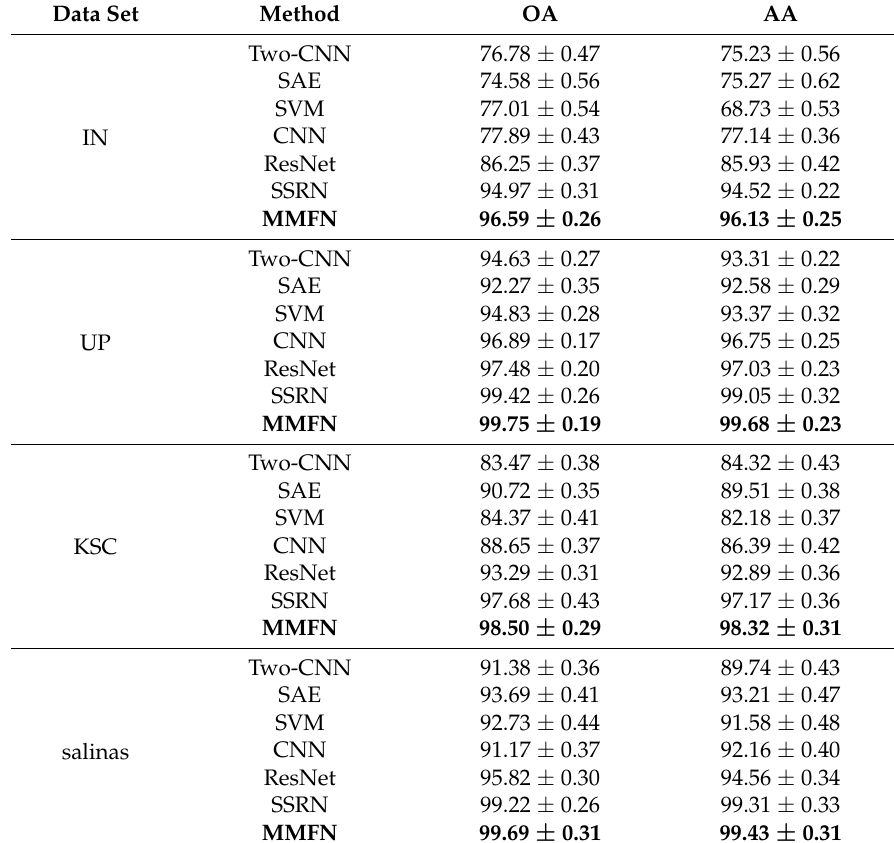
Table 8. Classification accuracies (%) of different methods on the four data sets.